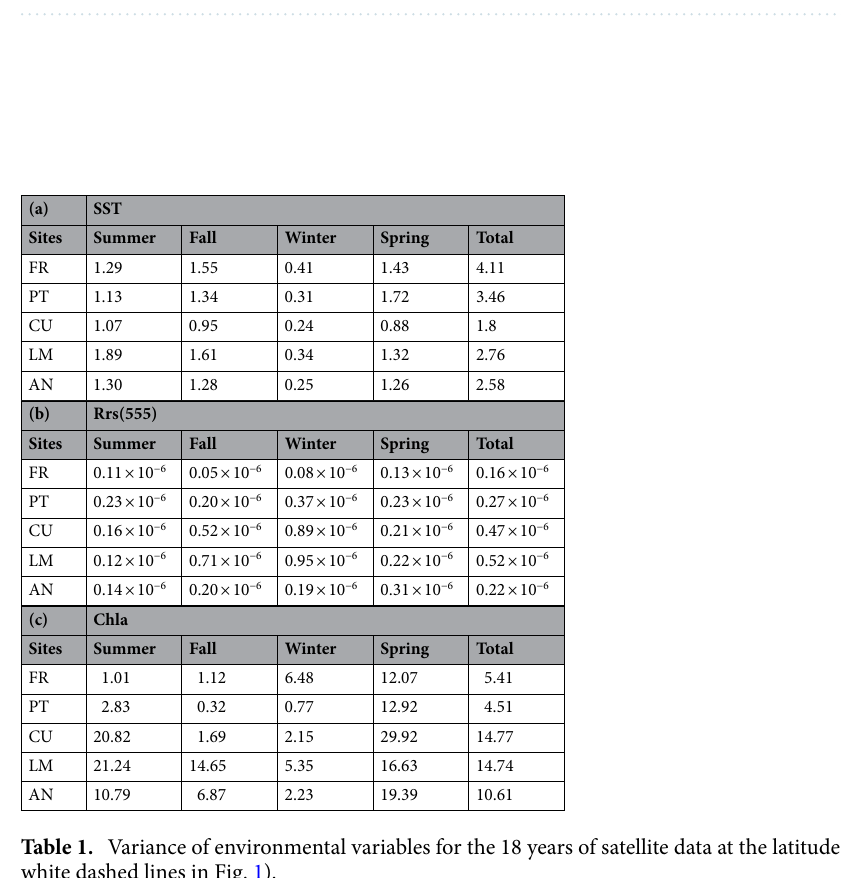
Figure 1. Map of the sampling area (redrawn from 20 ) and the long-term (2003–2020) monthly climatologies of the three proxies of biophysical variability. The climatologies (coastal band of 100 km) are represented from January to December along x ‐ axis, for both ( a ) sea surface temperature (SST, °C), ( b ) turbid river plumes [Rrs(555) (sr ‐ 1)] and ( c ) chlorophyll ‐ a (mg m ‐ 3). The white horizontal dashed lines denote the location of sampling sites. FR, El Frances; PT, Punta Tralca; CU, Los Cuernos; LM, Los Molinos; AN, Ancud. The map was created using the program Google Earth v7.3 (https:// www. google. com/ intl/ es/ earth/ versi ons/) and the software Photoshop v23.4.2 (https:// www. adobe. com/ cl/ produ cts/ photo shop. html).